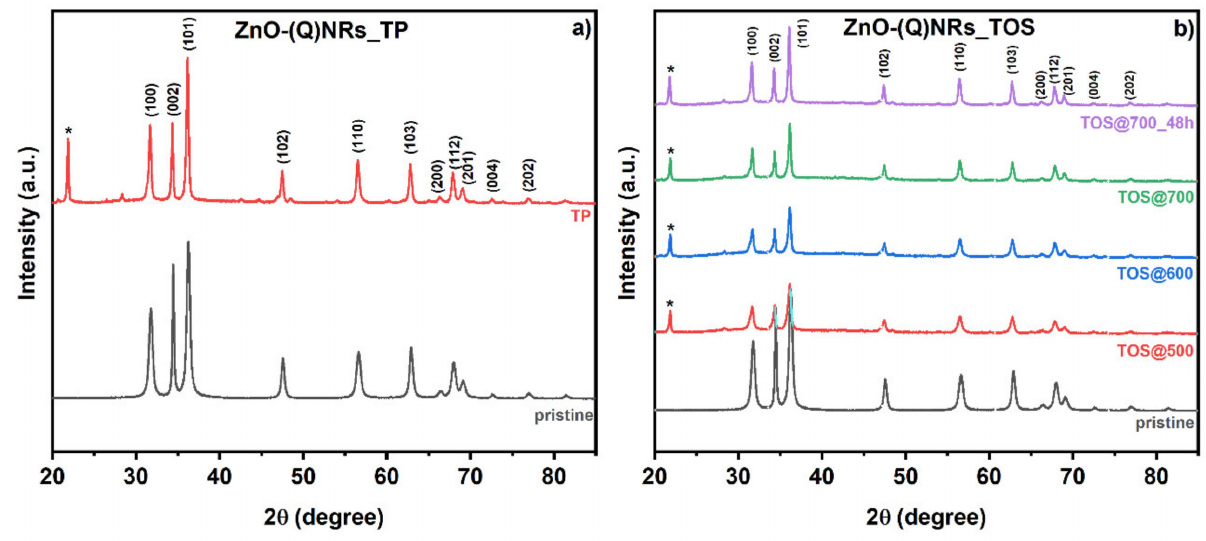
Figure 9. XRD patterns of ZnO-(Q)NRs ( a ) pristine and after use from 400 ◦ C to 700 ◦ C temperature range (TP), ( b ) pristine and after use at 500 ◦ C, 600 ◦ C, and 700 ◦ C in time on stream (TOS) reactions. The diffraction signal of the traces of quartz silica used as a dilutant is labeled with (*). The variation of surface area of the ZnO-(Q)NRs after use in the 400–700 ◦ C